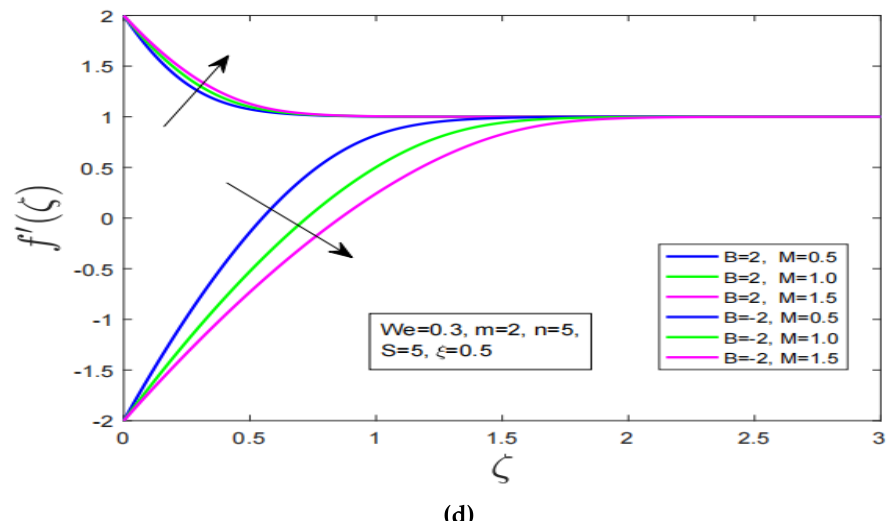
Figure 1. ( a ): Systematic representation of Physical model, ( b ): Effect of power law index on velocity profile over stretching and shrinking surface, ( c ): Impact of mass suction effect on velocity profile over stretching and shrinking surface, ( d ): Influence of magnetization on velocity profile over stretching and shrinking surface.